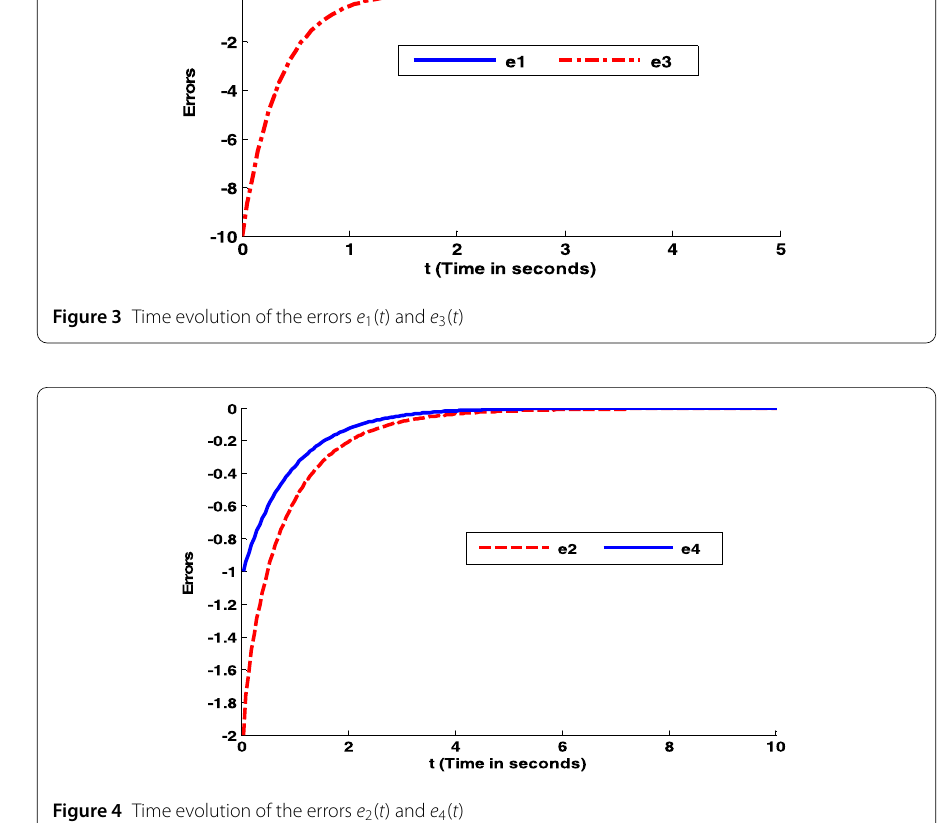
Figure 4 Time evolution of the errors e 2 ( t ) and e 4 ( t